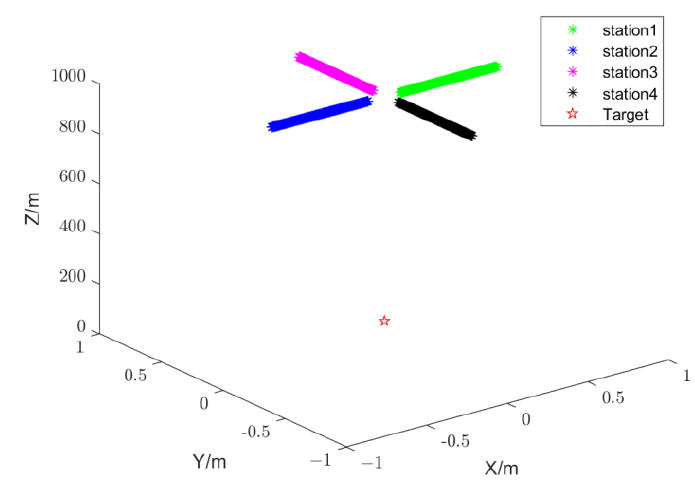
Figure 3. Simulated positioning trajectory.